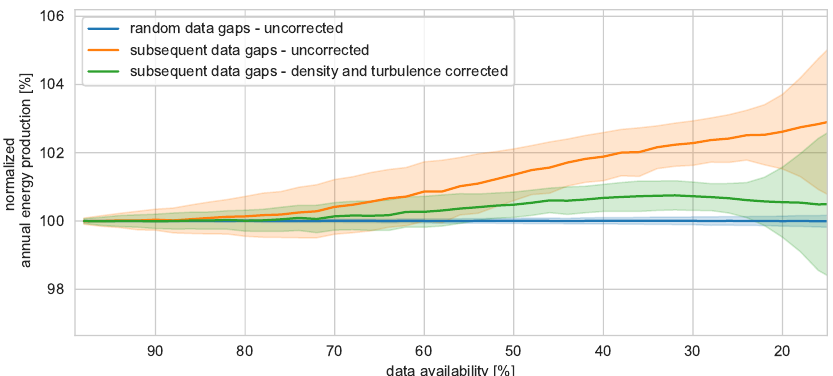
Figure 5. Effect of decreasing data availability on the uncertainty of power curves. The uncertainty is represented by deviations in the calculation of a generic annual energy yield using a rayleigh wind speed distribution (6.45 m/s) as reference.